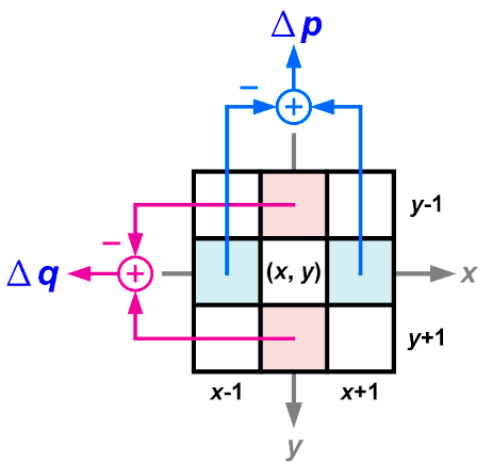
Figure 5. Variations of the detection point on x and y axes in a 3 × 3 mask.